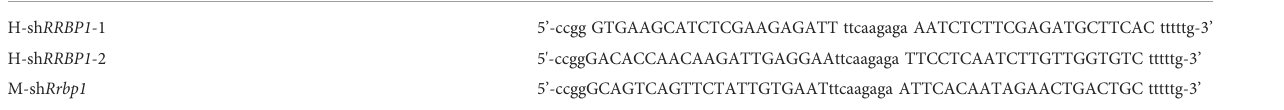
TABLE 1 The short hairpin RNA sequences for